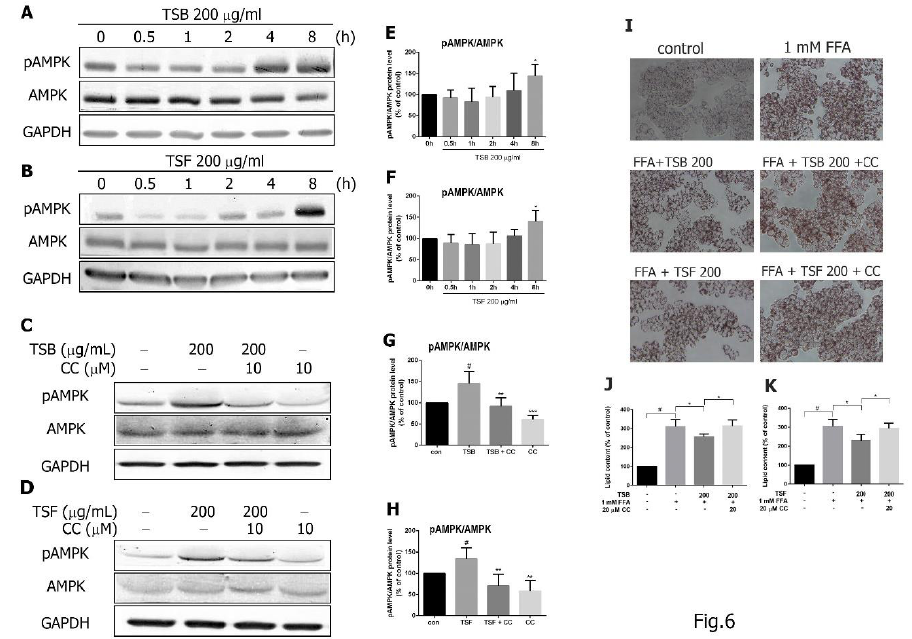
Figure 6. TSB and TSF extracts ’ effects on AMPK activation in HepG2 cells. ( A – D ) Immunoblots of phosphorylated AMPK expression in HepG2 cells. Total AMPK and GAPDH were used as the internal control. ( E – H ) The bar graphs show densitometric data (mean ± SD) from three to ten independent experiments. ( I ) Oil Red O staining. ( J and K ) Quantification of lipid contents. # P < 0.05 compared with the control group (0 h). * P < 0.05 compared with the FFA group. ** P < 0.01 and *** P < 0.001 compared with the FFA group. Scale bar = 50 m.